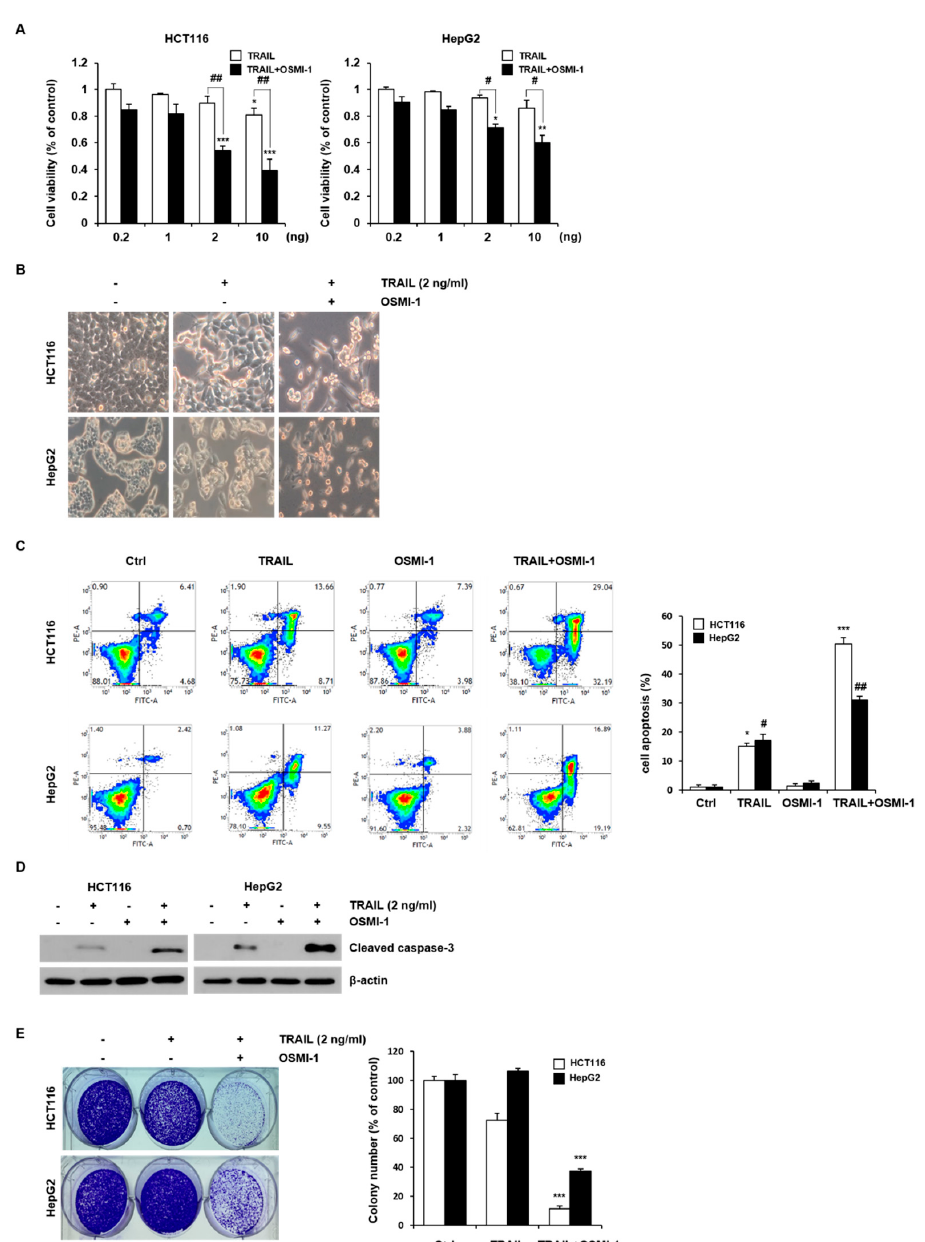
Figure 1. Combination treatment of TRAIL and OSMI-1 in HCT116 and HepG2 cells. ( A ) Two cancer cell lines (HCT116